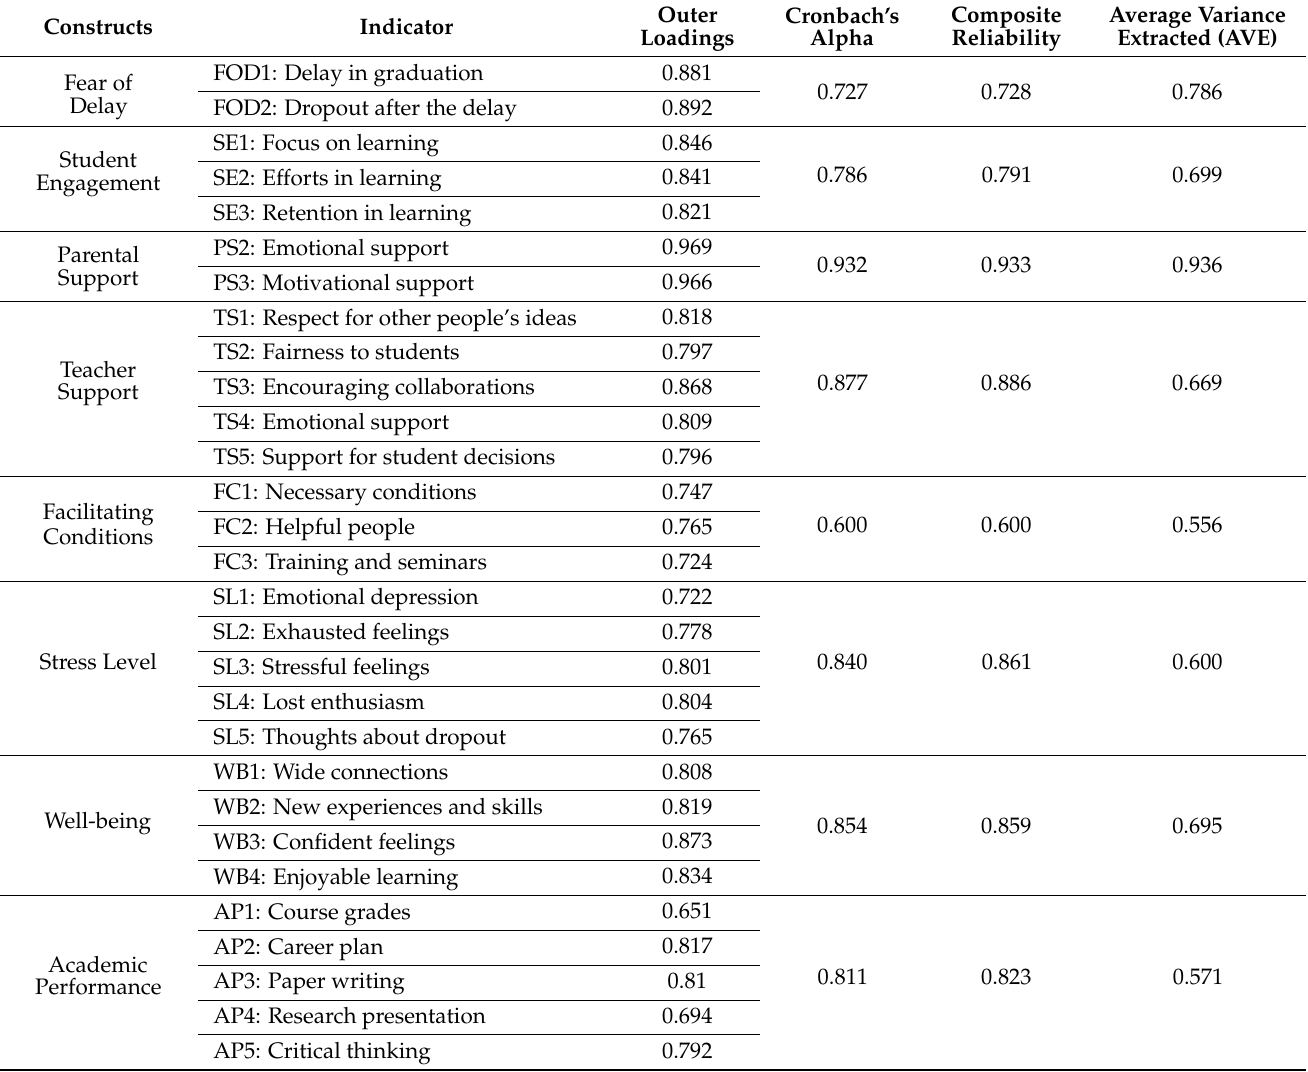
Table 3. Outer loadings, reliability, and convergent